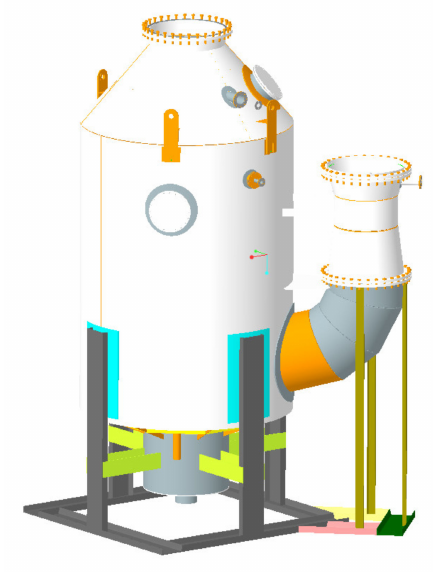
Figure 2. 3D Computer Aided Design (CAD) model of the scrubber.